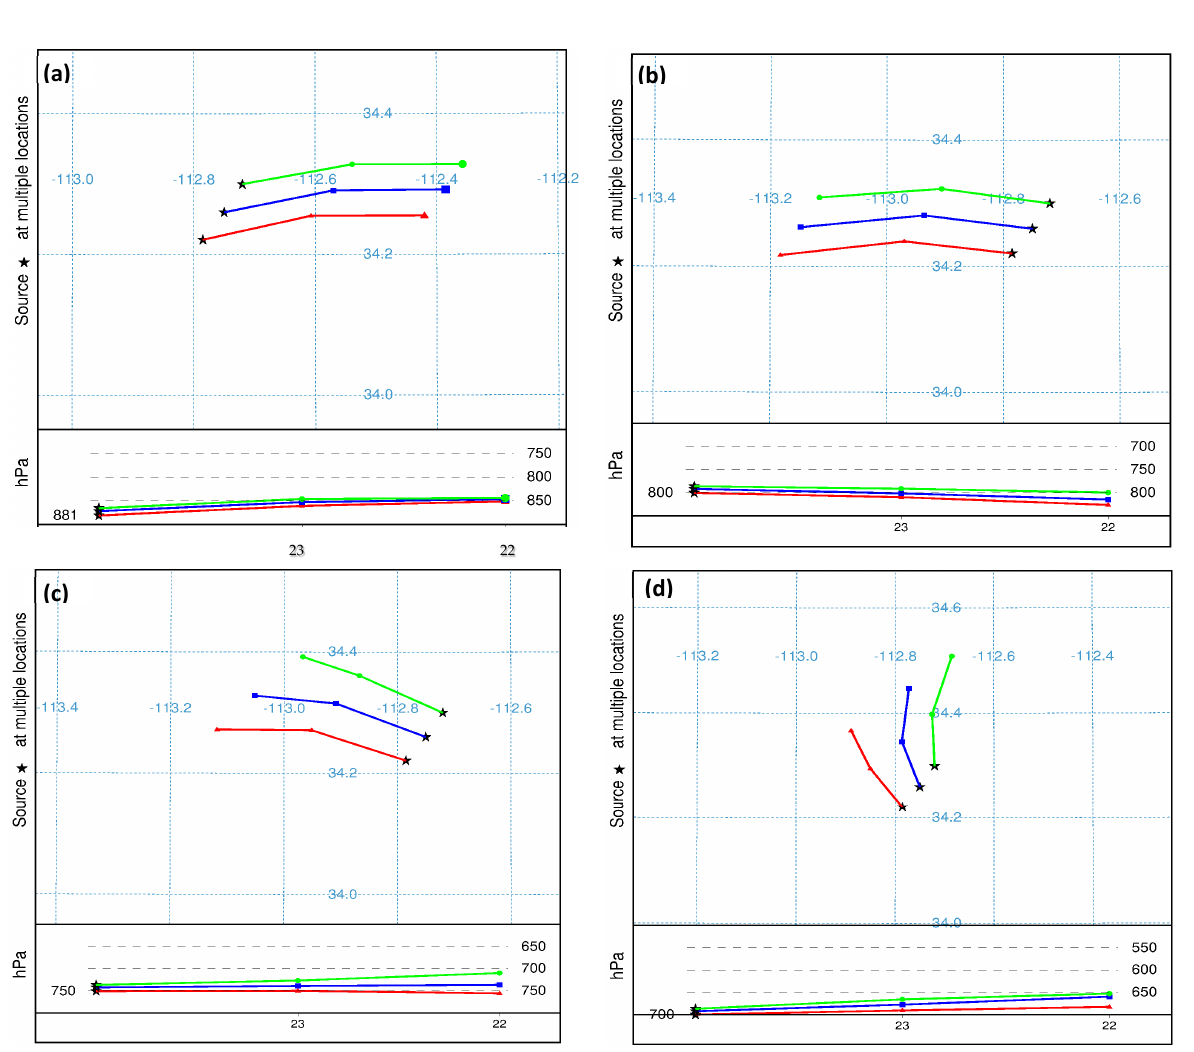
Figure 10. WRF-LES 259 m simulated backward trajectory parcels starting ~0 (red), 4.5 (blue), and 10 km (green) northeast of the Hotshots’ location along cross-section C-D from the ( a ) surface, ( b ) 850 hPa, ( c ) 800 hPa, and ( d ) 750 hPa at 2350 UTC through the end of the simulation.